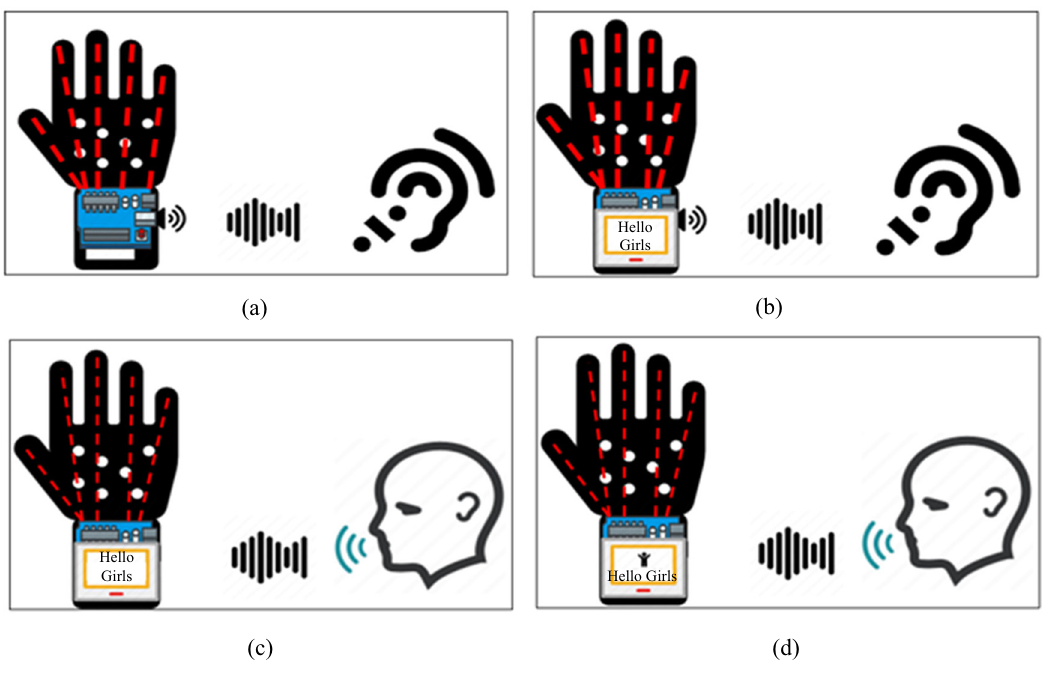
Figure 7: Prototype scenario of sprint ( a ) converting sign language into voice, ( b ) converting sign language into text, ( c ) converting voice into texts, and ( d ) converting voice into sign language by an avatar on the